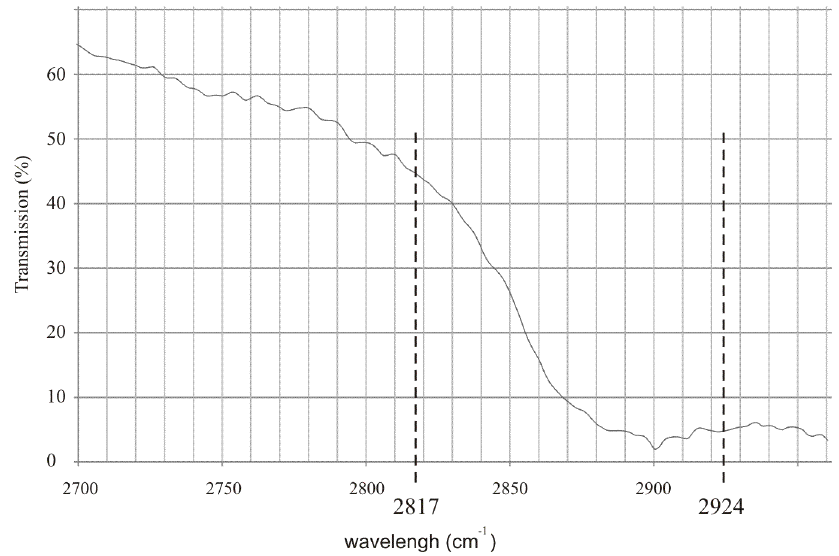
Figure 1. Experimental transmission spectrum of the rectified spirit along with the wavelengths of commercially available inter-band cascade lasers.